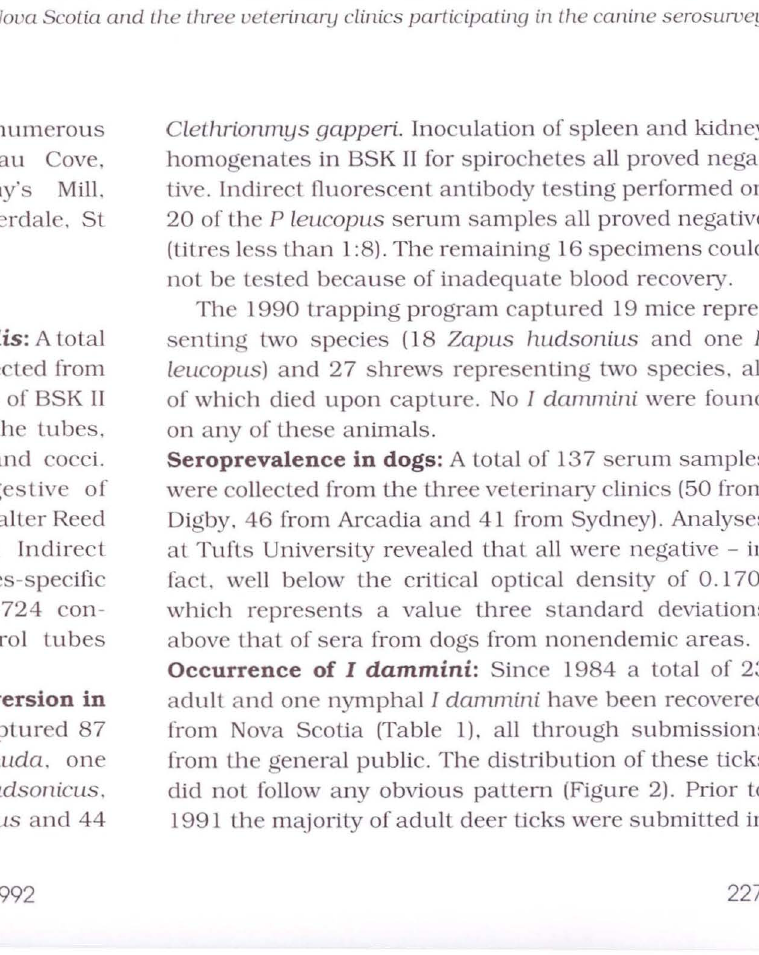
Figure 2) Location of Ixodes dammini recovered in Nova Scotia and the three veterinary clinics participating in tile canine serosurvey